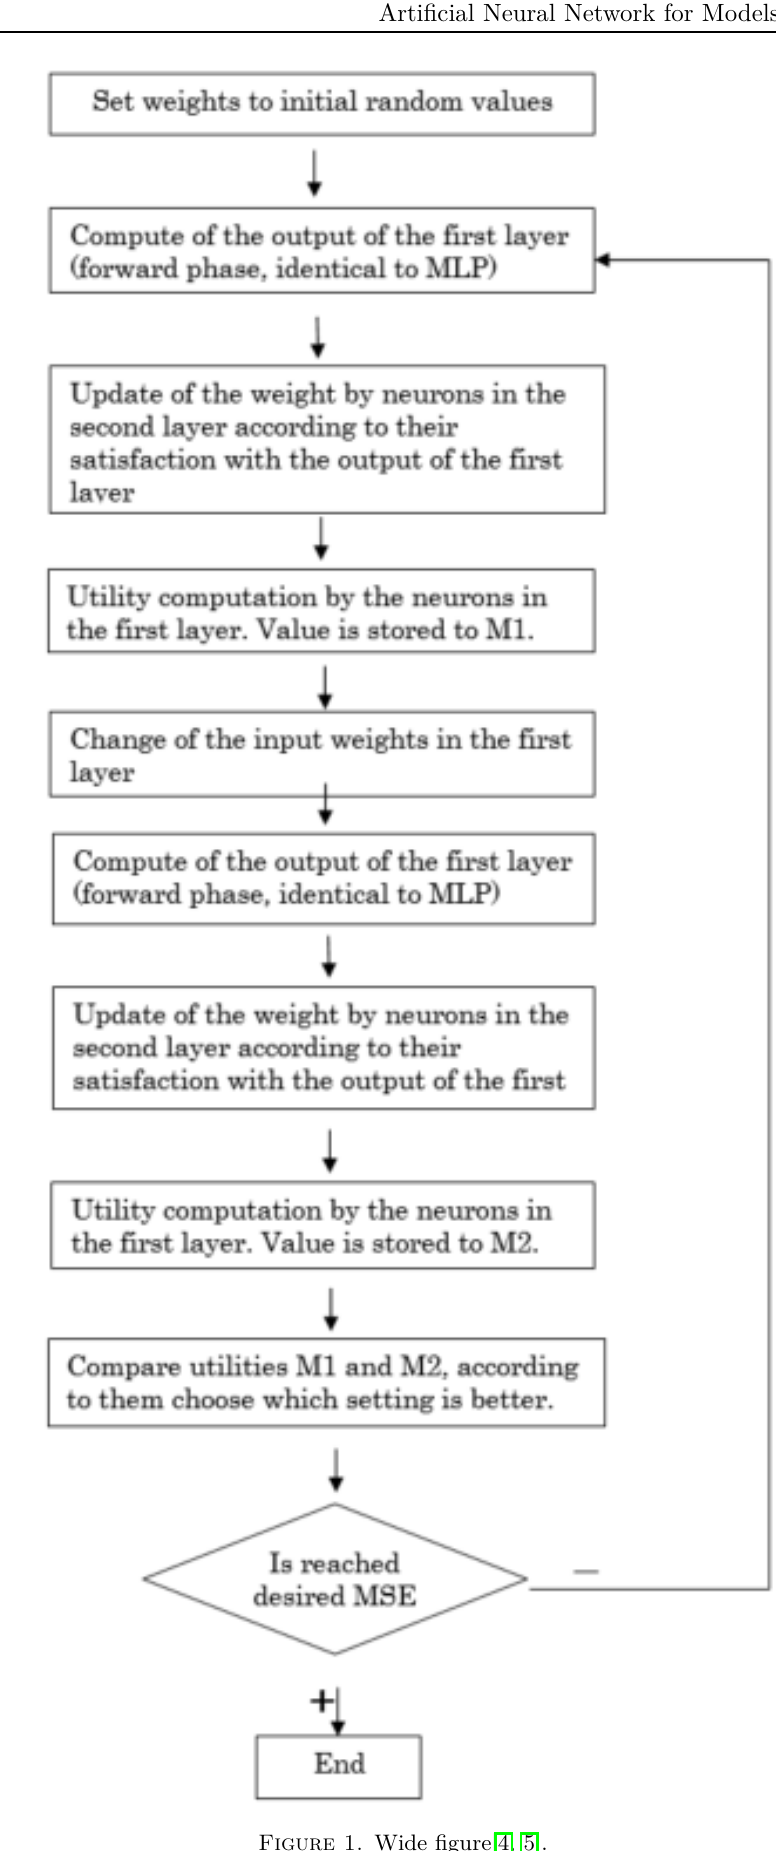
Figure 1. Wide figure[4,